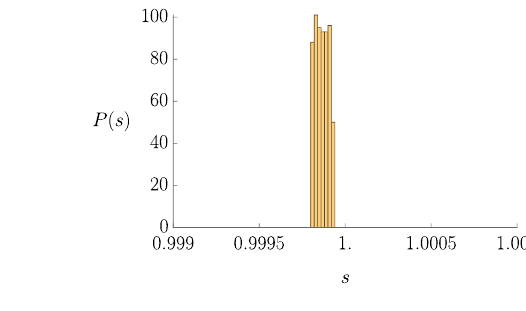
Figure 3 . Spacing distribution typical for clock behaviour . The right is a zoom-in of the left plot that emphasizes the small spread of the distribution. Here we used the electrostatics problem for a quartic potential V = − 1 / 2 x 2 + x 4 , again we used the binsize 1 / 10 centered around zero and took L = 10 4